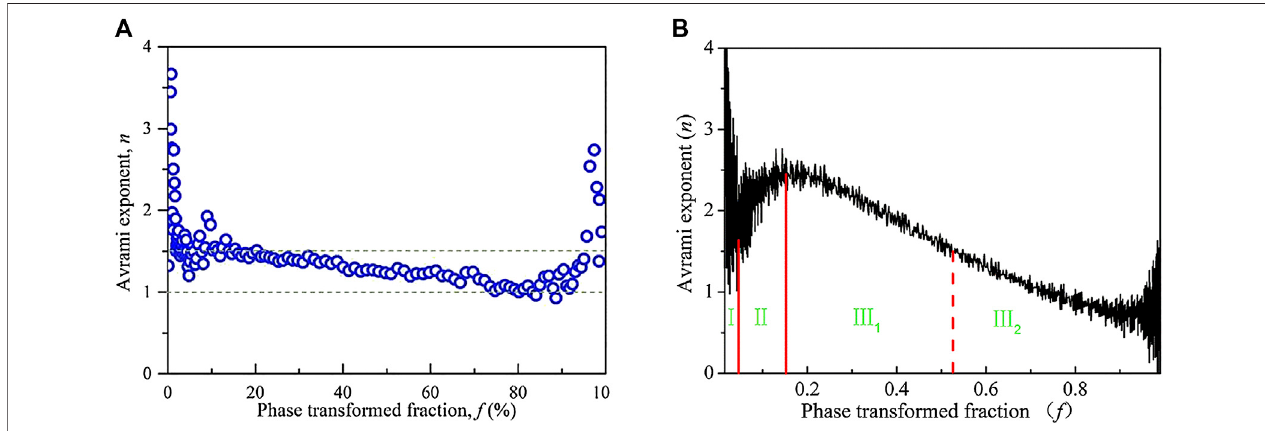
FIGURE2|(A) ThelocalAvramiexponent(bluecircle)asafunctionofphasetransformed fractionofAl 0.25 CoCrFeNi HEA(4 K/min).Thegreenzonerepresentsthe range of n from 1 to 1.5 (Wang et al., 2018b). (B) Variation in n with the increasing volume fraction of Al 0.5 CoCrFeNi HEA (3 K/min). (Wang et al.,